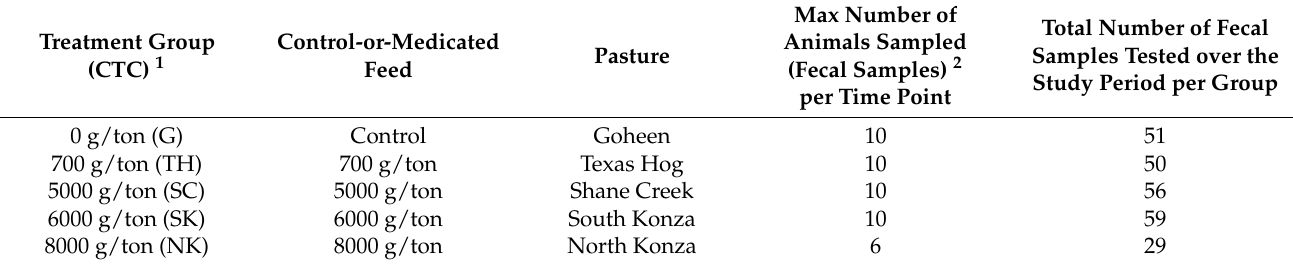
Table 1. Treatment groups and the number of fecal samples collected for analysis.